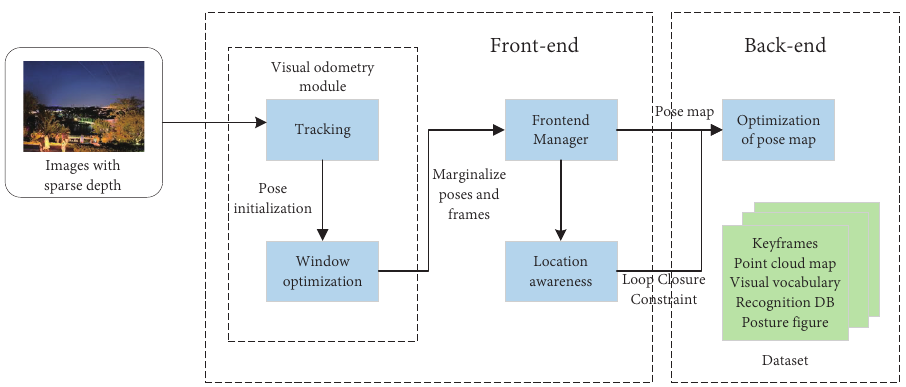
Figure 19. Frame diagram of DVL-SLAM. The input data are pictures with a relevant sparse depth, which are used for the tracking process. The front-end uses window optimization and data associ- ation for accurate motion estimation, and the back-end accepts the front-end data for global pose map